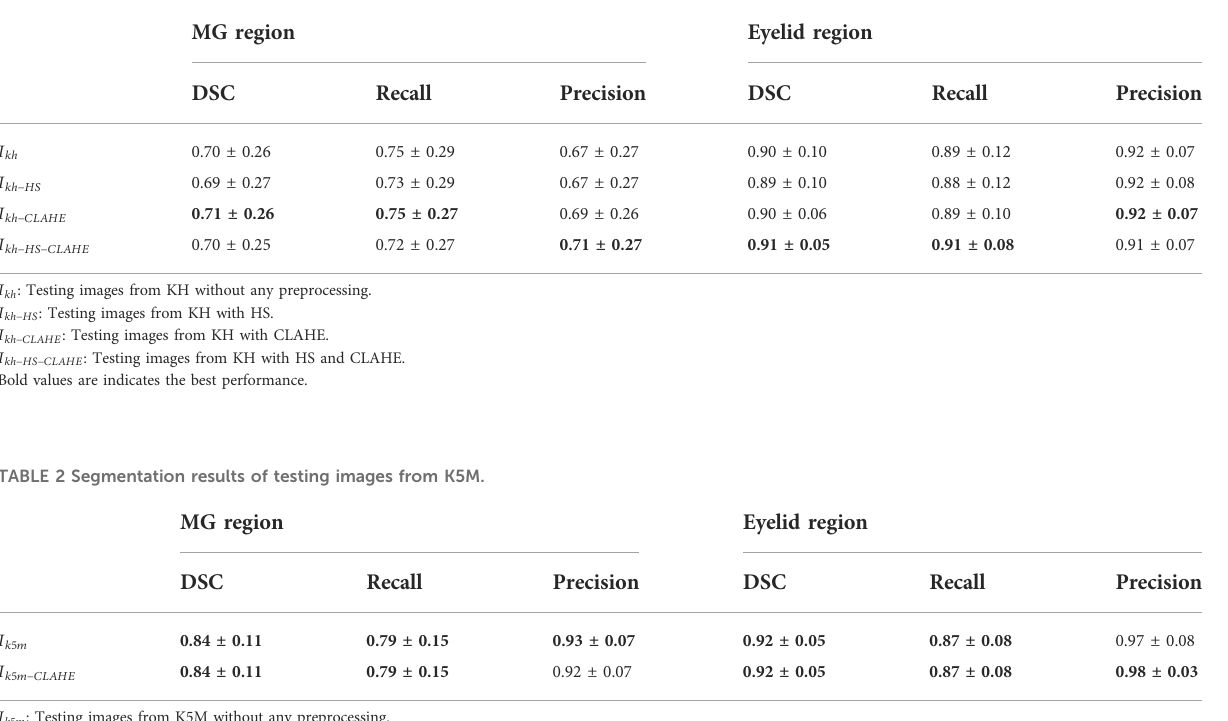
TABLE 1 Segmentation results of testing images from KH.